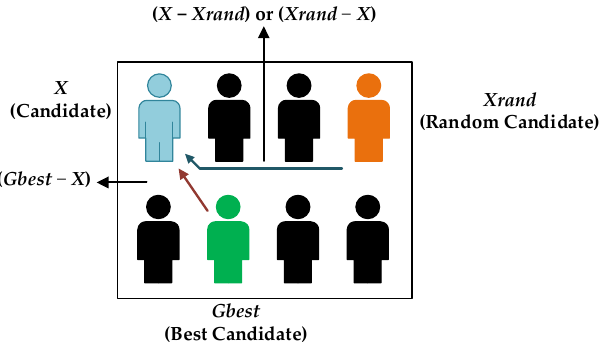
Figure 6. G best candidate of the group in the SGO algorithm.